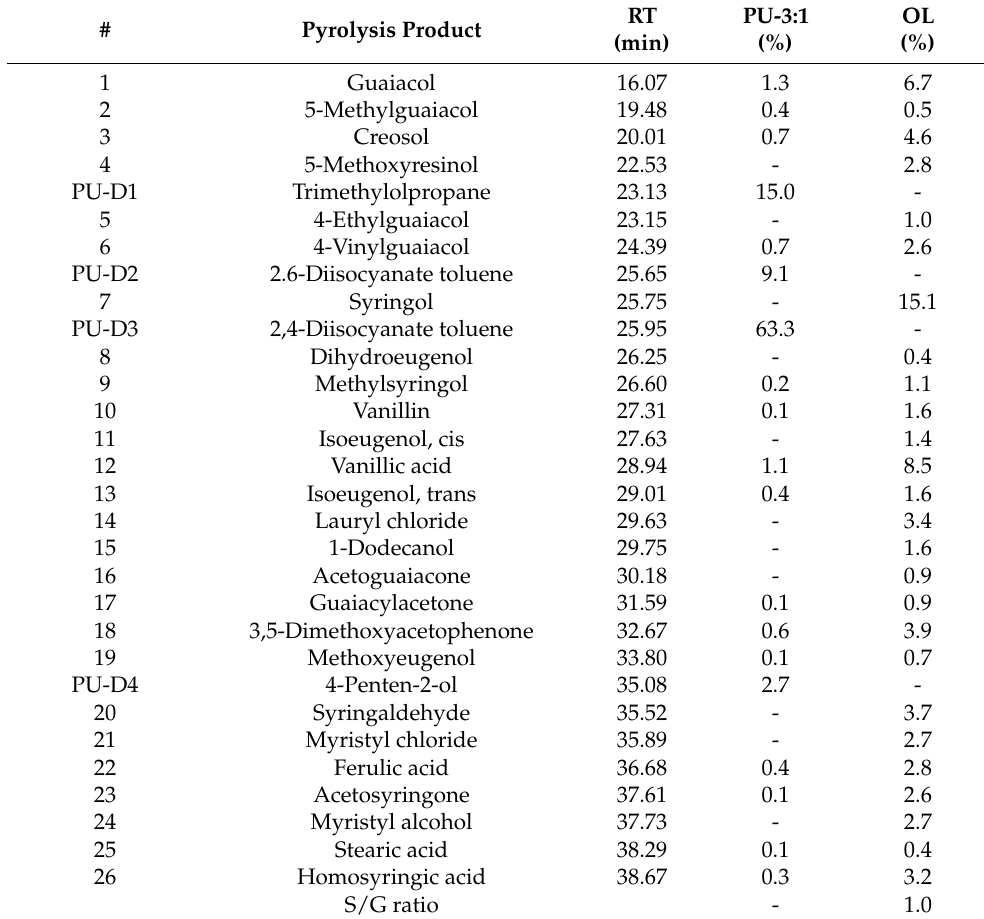
Table 5. Retention times, relative abundances, assignment to guaiacyl-type (G) or syringyl-type (S) aromatic lignin subunits of pyrolysis products and respective S/G ratios of the Organosolv lignin (OL) used and one of the produced PU sample